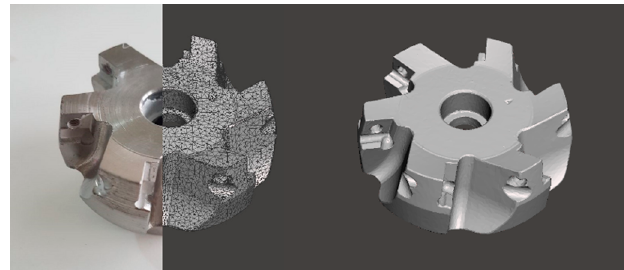
Figure 9. The resulting 3D polygonal model and picture of the milling cutter.